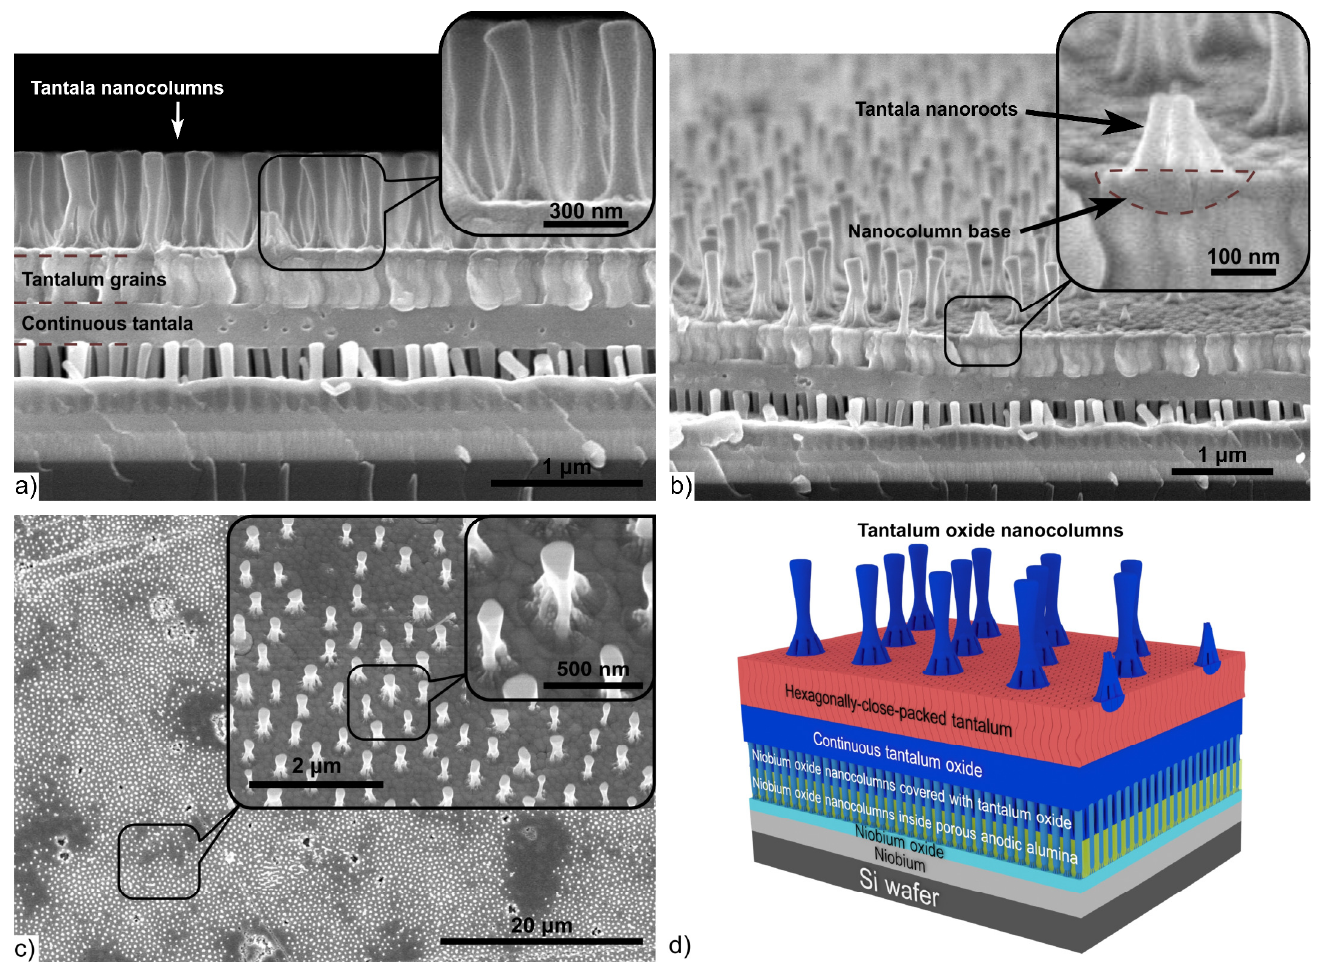
Figure 6. SEM cross-fractured ( a , b ), surface ( c ) and 3D schematic views ( d ) of the second-level column-like niobia 3D nanofilm with hexagonally close-packed tantala. Images shown in ( a – c ) were taken after the second-level PAA layer had been dissolved away. Table 3. Morphological parameters of second-level